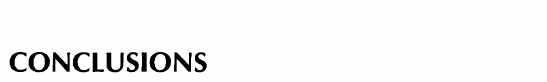
FIGURE 11 Illustration of three bay truss finite ele ment model.